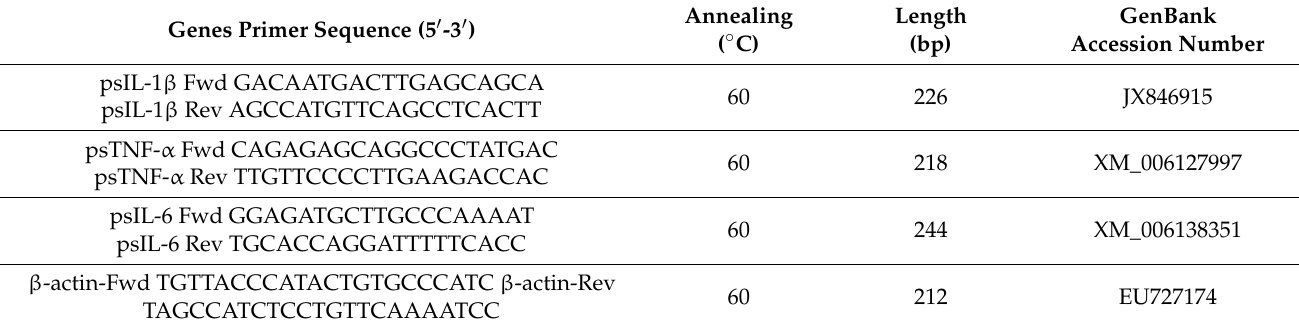
Table 1. Primers and annealing temperature for real-time